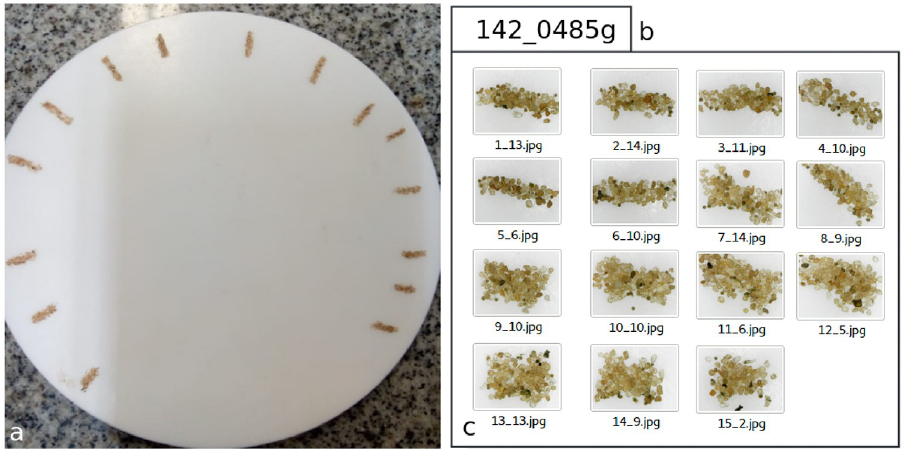
Fig 4. The testing set building process: a) The substrate split into small portions on a white coverslip. b) Folder name (label) that indicates the amount of cyst (142) and the weight of the substrate (0.485g) contained in the folder. c) Sample of images in folder captured by the XTRAD USB digital microscope model XT-2036. The file name indicates the image number and amount of cyst contained in it. For example, in the 1_13.jpg file, 1 indicates the file number and 13 indicates the number of cysts in the